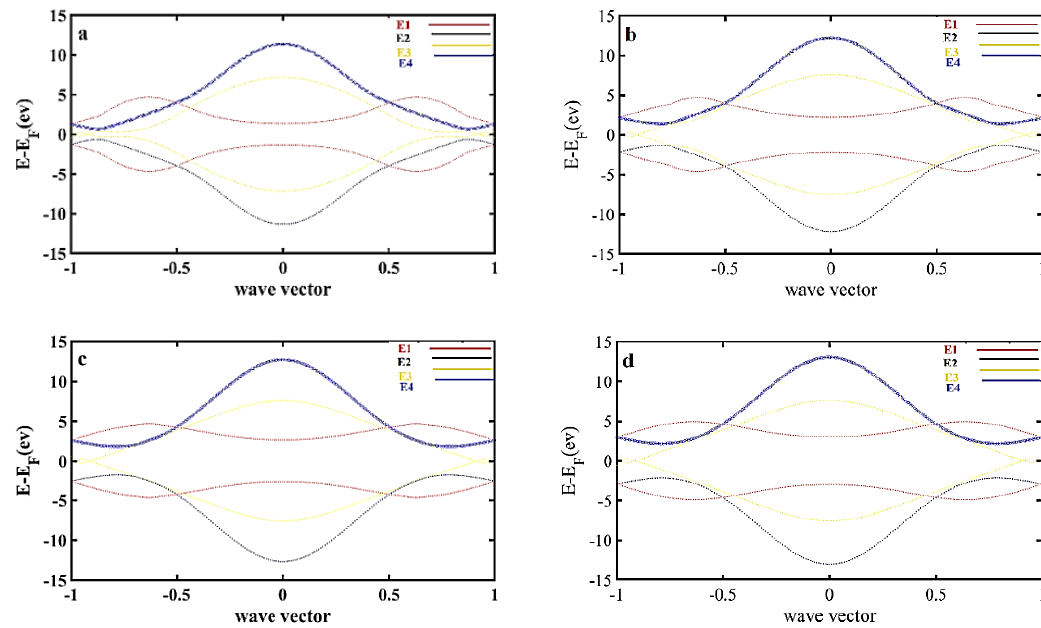
Figure 4. ( a ) t = 2.59 ev, tp = 1 ev; ( b ) for t = 2.59 ev, tp = 2 ev; ( c ) t = 2.59 ev, tp = 2.5 ev; ( d ) t = 2.5 ev, Figure 4. a ) t = 2.59 ev, tp = 1 ev; b ) for t = 2.59 ev, tp = 2 ev; c ) t = 2.59 ev, tp = 2.5 ev; d ) t = 2.5 ev, tp = tp = 2.83 2.83 ev.